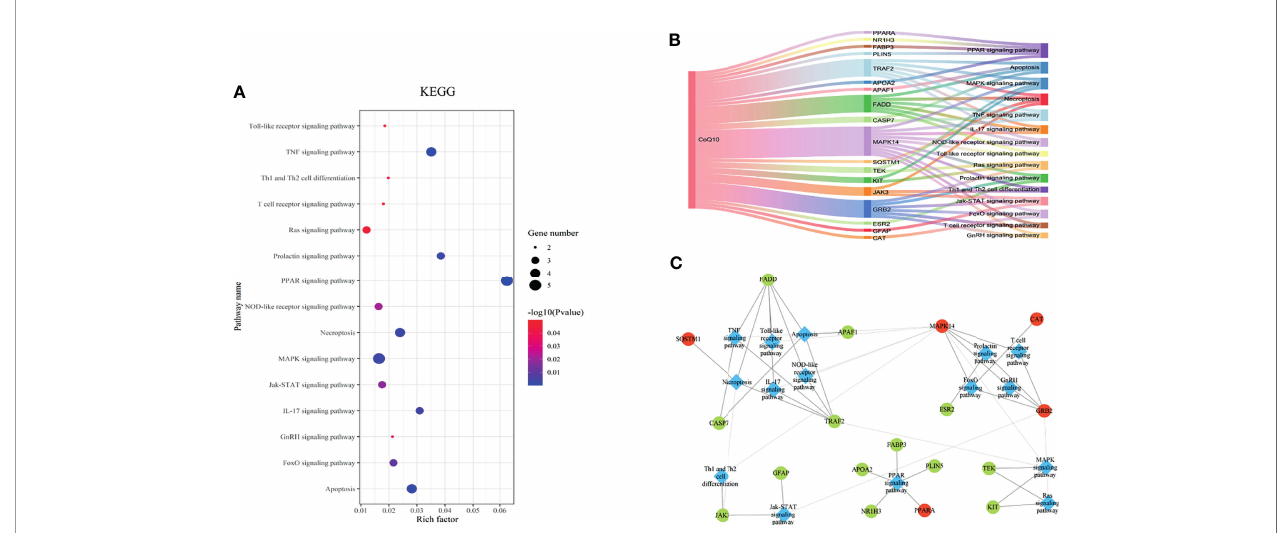
FIGURE 4 | The KEGG pathway analysis of the 27 potential therapeutic targets. (A) The 15 signi fi cant pathways. The bubbles ’ sizes are indicated from big to small in descending order of the count of the potential targets enriched in the pathways. The bubbles ’ colors are indicated from red to blue in descending order of -lg ( p- value). (B) CoQ10-targets-pathways network. The width of the line is proportional to the number of connected points. (C) Module analysis of the target-pathway network. The diamond nodes represent the pathways, and the ellipse nodes represent the targets. The red nodes represent the hub genes obtained from the PPI network of potential therapeutic